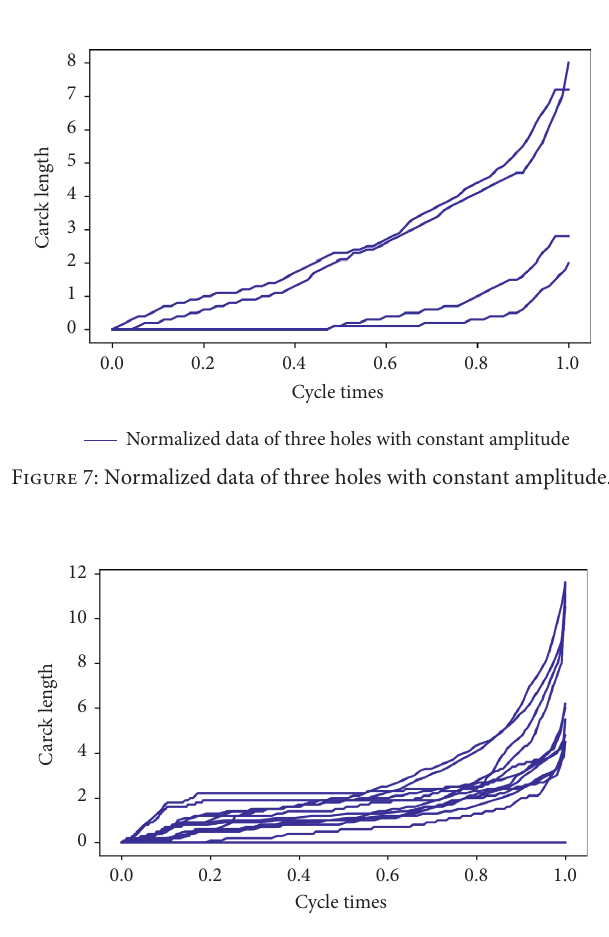
Figure 8: Normalized data of two holes with variable amplitude.